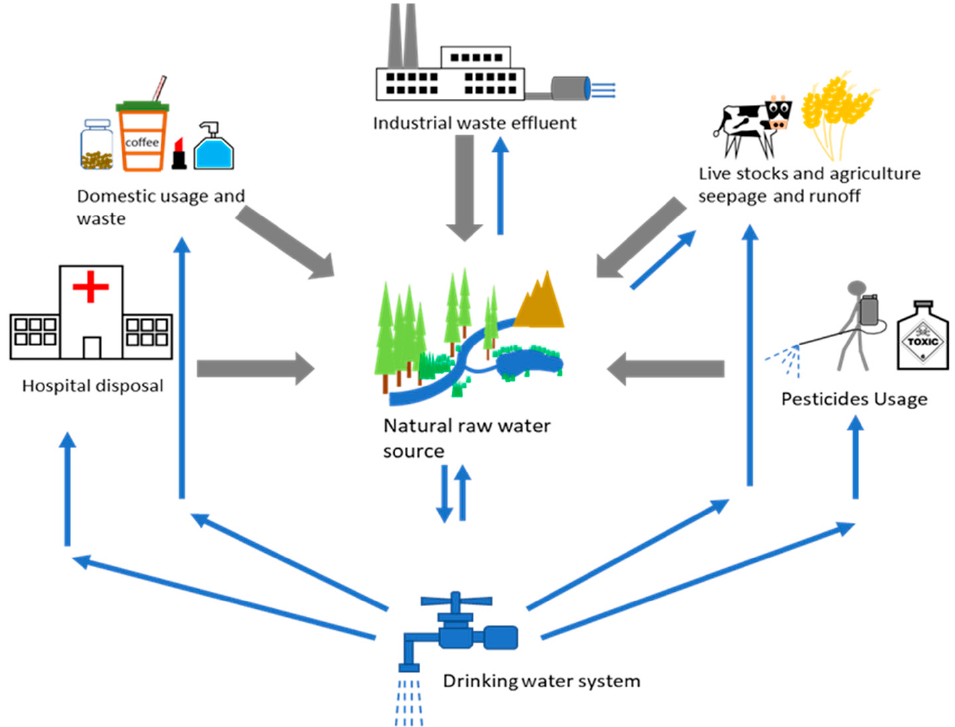
Figure 1 . The schematic of water contamination sources and pathways in the water cycle Figure 1. The schematic of water contamination sources and pathways in the water